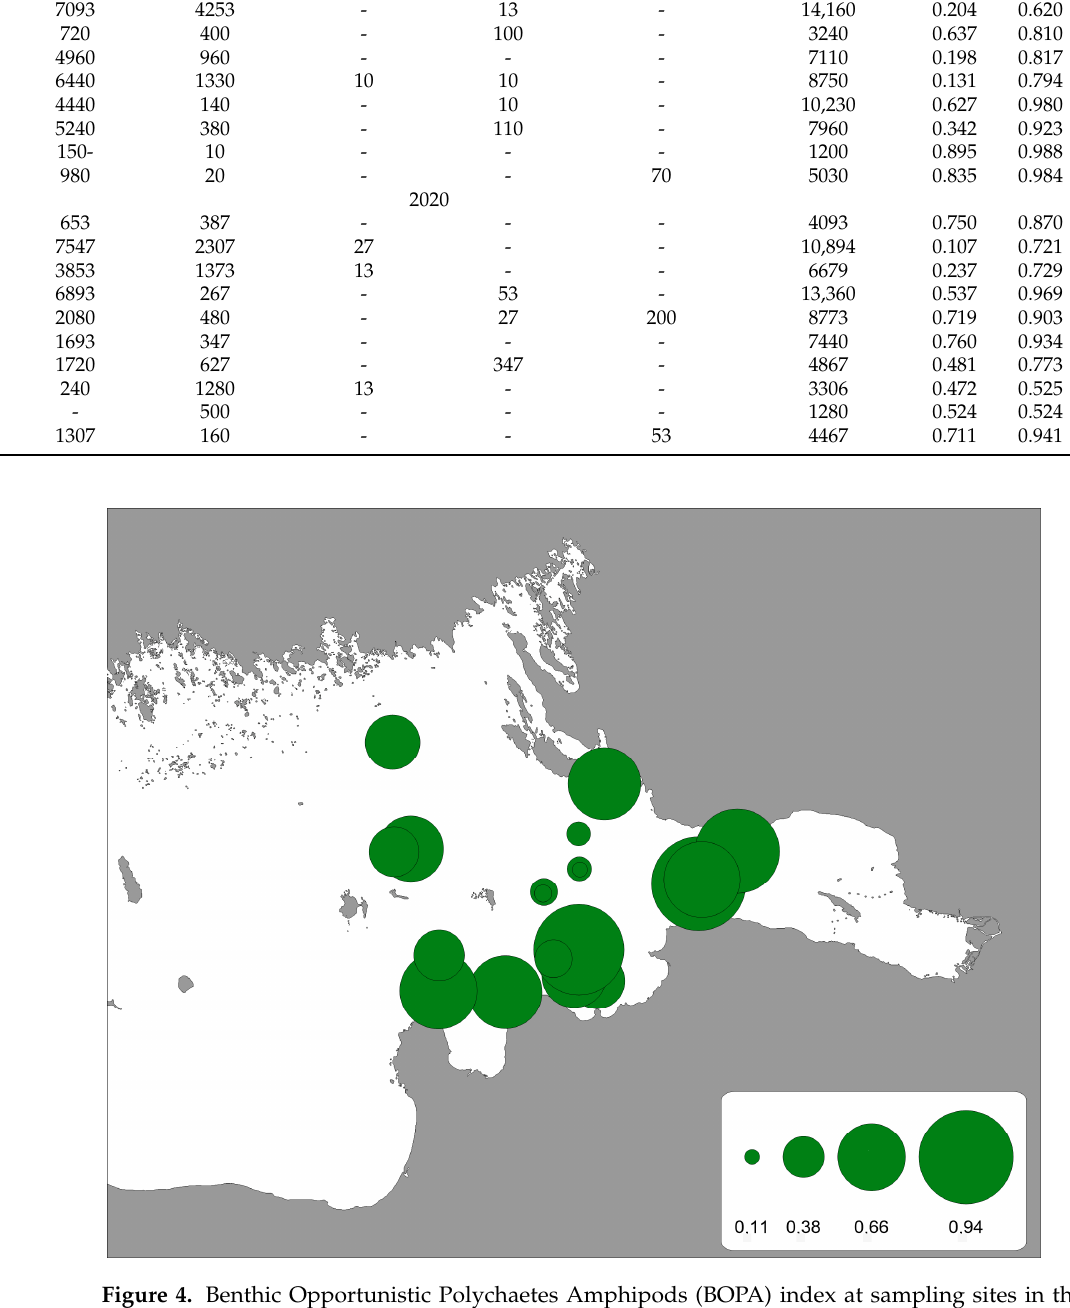
Table 1. Abundance (ind. m − 2 ) of macrobenthic taxa, Benthic Opportunistic Polychaetes Amphipods (BOPA) and Benthic Opportunistic Annelida Amphipods (BO2A) indices. Coastal sites are marked in bold.